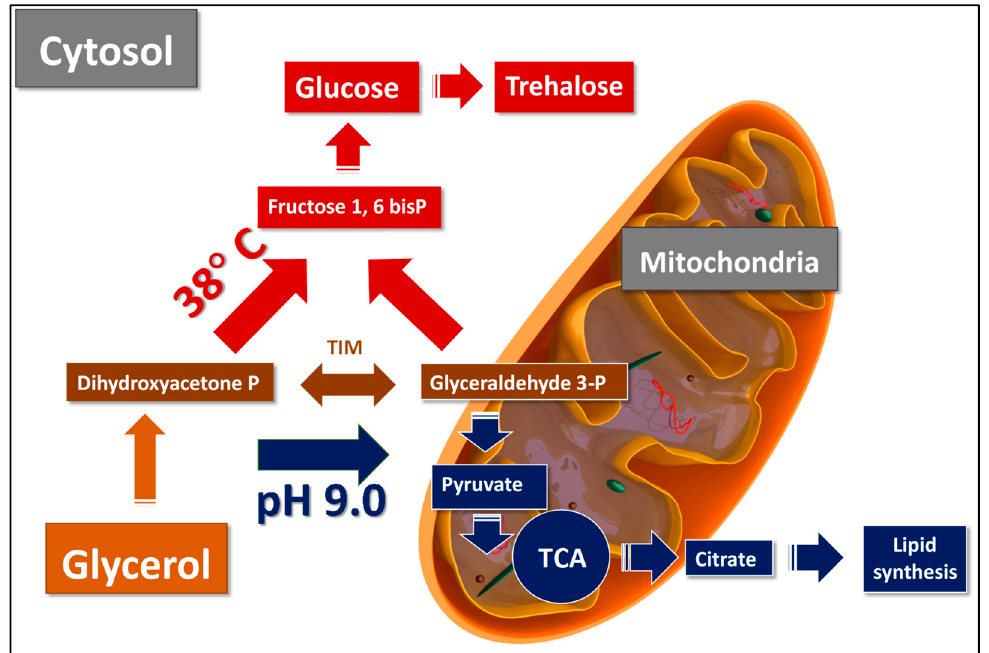
temperature, glycerol is metabolized, forming glucose in the cytoplasm in the reactions of gluconeogenesis and the subsequent synthesis of trehalose. At extreme pH, pathways shift towards the oxidative metabolism of glyceraldehyde-3- phosphate into pyruvate in the mitochondria, its implication in the Krebs cycle followed by forming citrate, its transport into the cytosol, and inclusion into lipid biosynthesis. According to Workman et al. [25], glyceraldehyde-3-phosphate can be